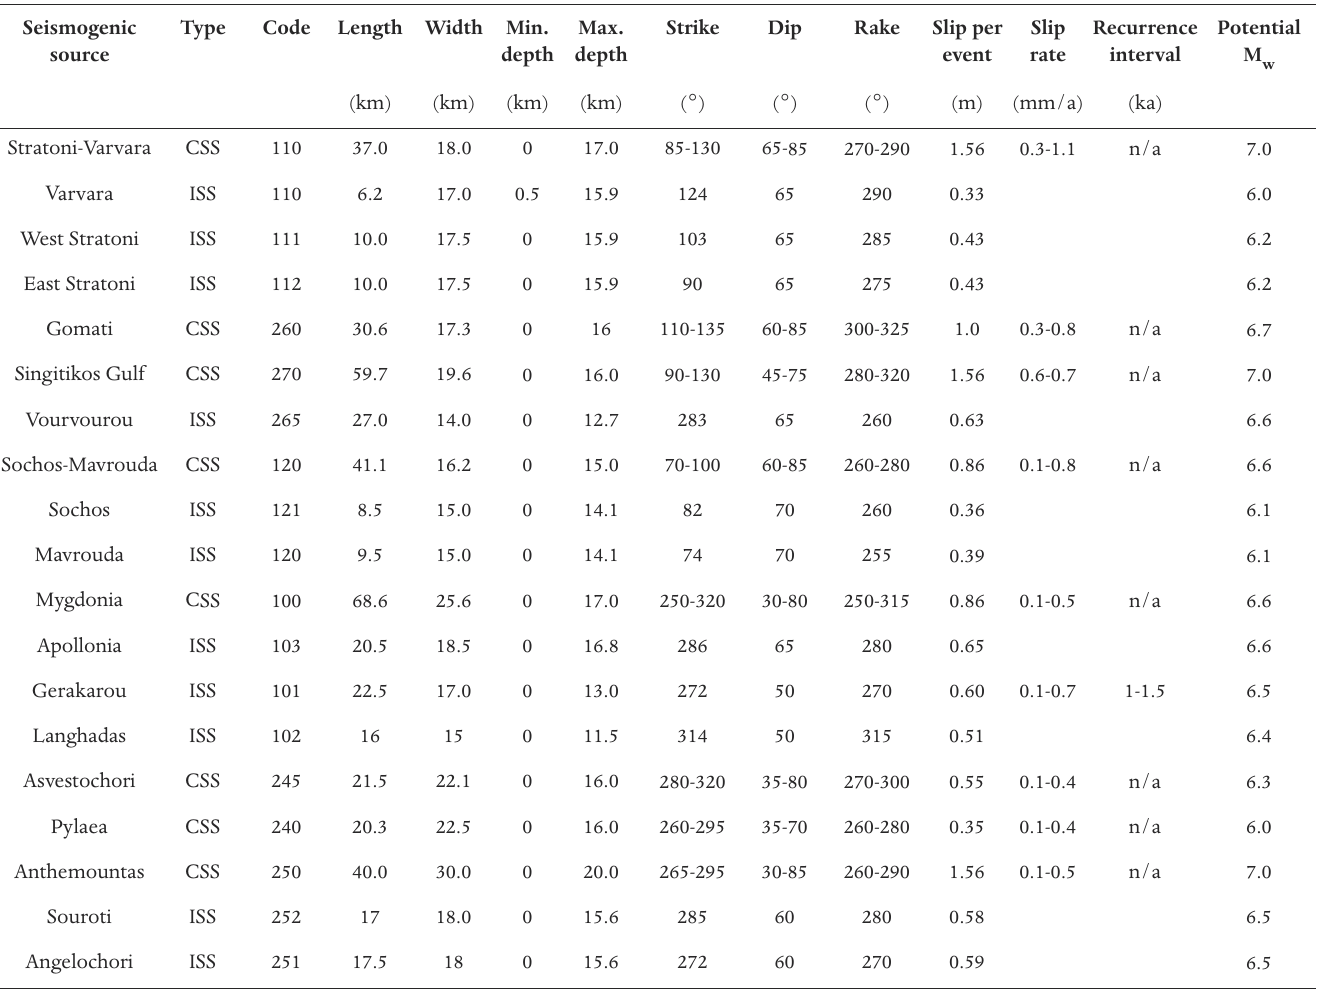
Table 3. Seismotectonic parameters of the CSSs and ISSs included in the Chalkidiki fault system (see Figure 4). CSS, composite seismogenic source; ISS, individual seismogenic source; Code, identification number within the database; n/a, not